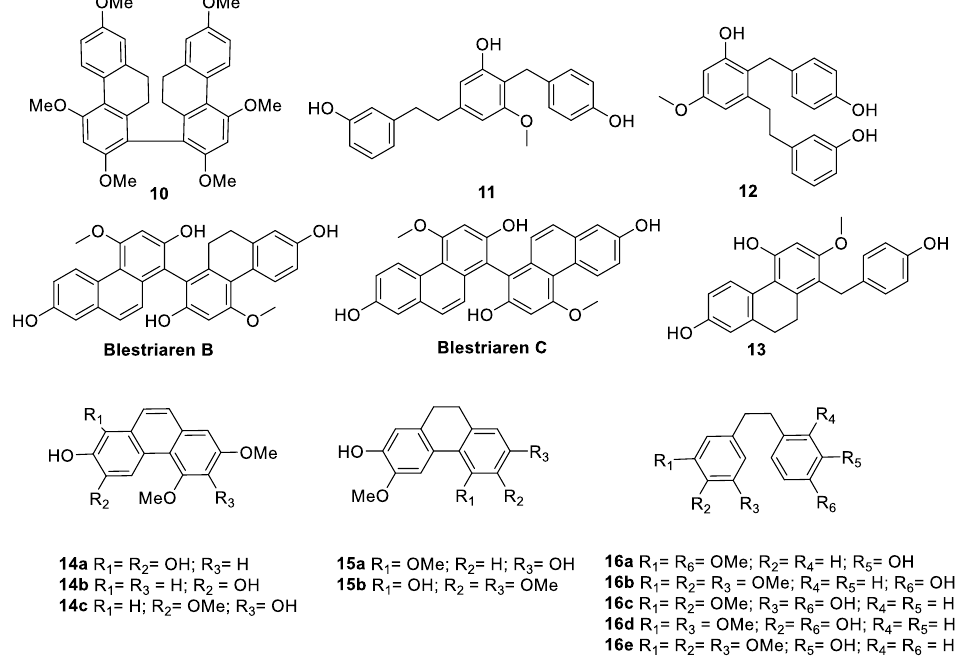
Figure 8. Structures of compounds isolated from Bletilla yunnanensis Schltr. from Yang et al. (2016) [72] and from C. hereroense , C. collinum , and C. apiculatum from Katerere et al. (2012) [73]. Table 11. Antimicrobial activity of compounds 10–13 in MIC values, µ g / mL from Yang et al. (2016) [72]. Compound S. aureus